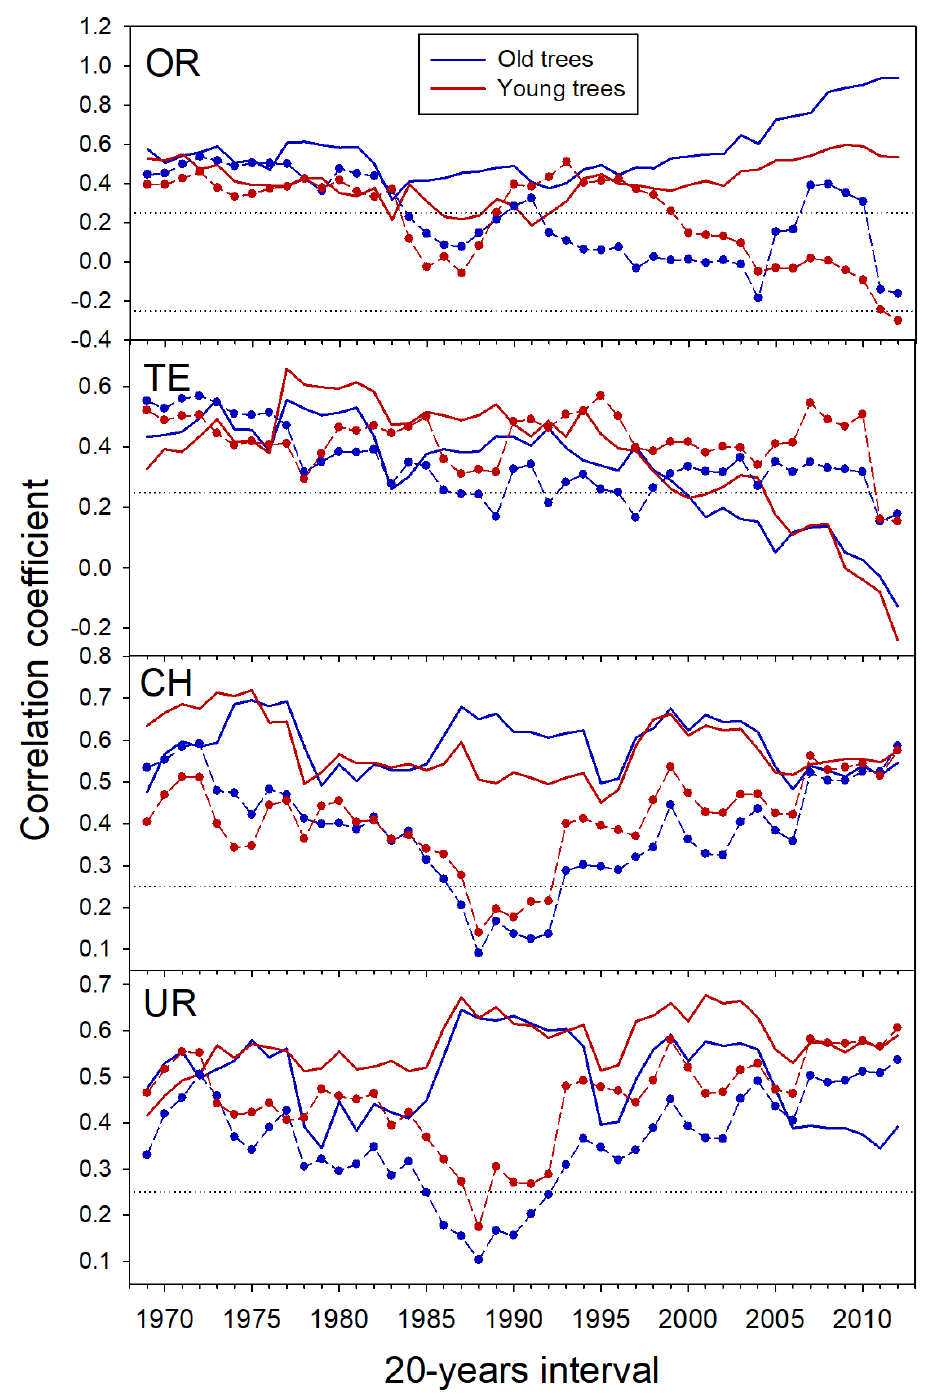
Figure 3. Temporal changes in bootstrapped correlation coefficients using 20-year long intervals shifted by one year for the period 1950–2012 (values are arranged for the last year of each 20-year long interval). Dashed horizontal lines indicate statistically significant correlation coefficients ( p < 0.05) for previous maximum November temperature (lines) and current minimum May temperature (symbols) in Pinus uncinata Pyrenean treelines (OR, TE); current (year t) maximum July temperature (lines) and current minimum July temperature (symbols) in Urals Larix sibirica treelines (CH, UR). Sites’ codes are as in Table 1.